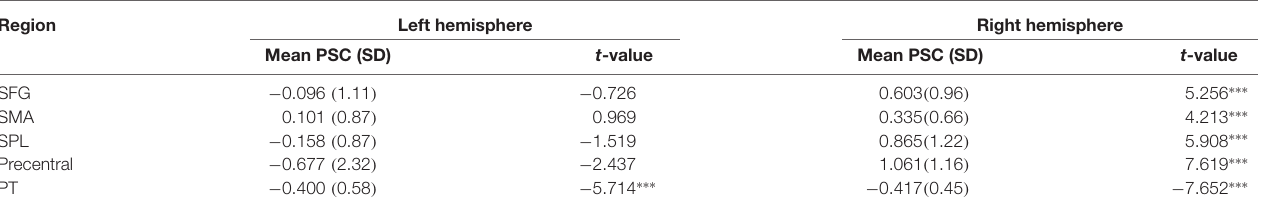
TABLE 5 | Grammaticality effect of EFs-specific ROIs per hemisphere.